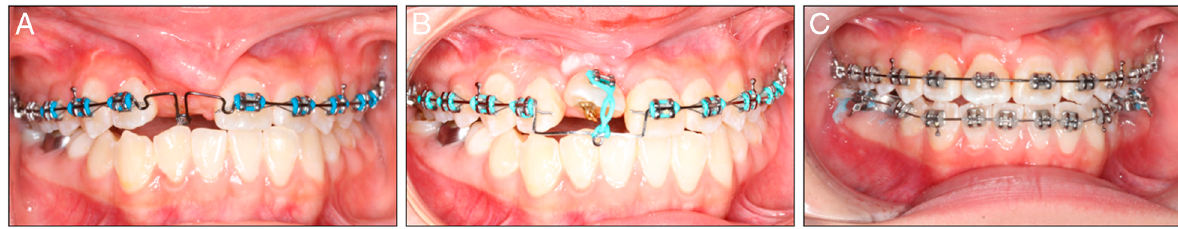
Figure 8. (A) The Ballista spring to encourage more vertical movement; (B) Power chain to encourage palatal crown movement; (C) 11 achieved final